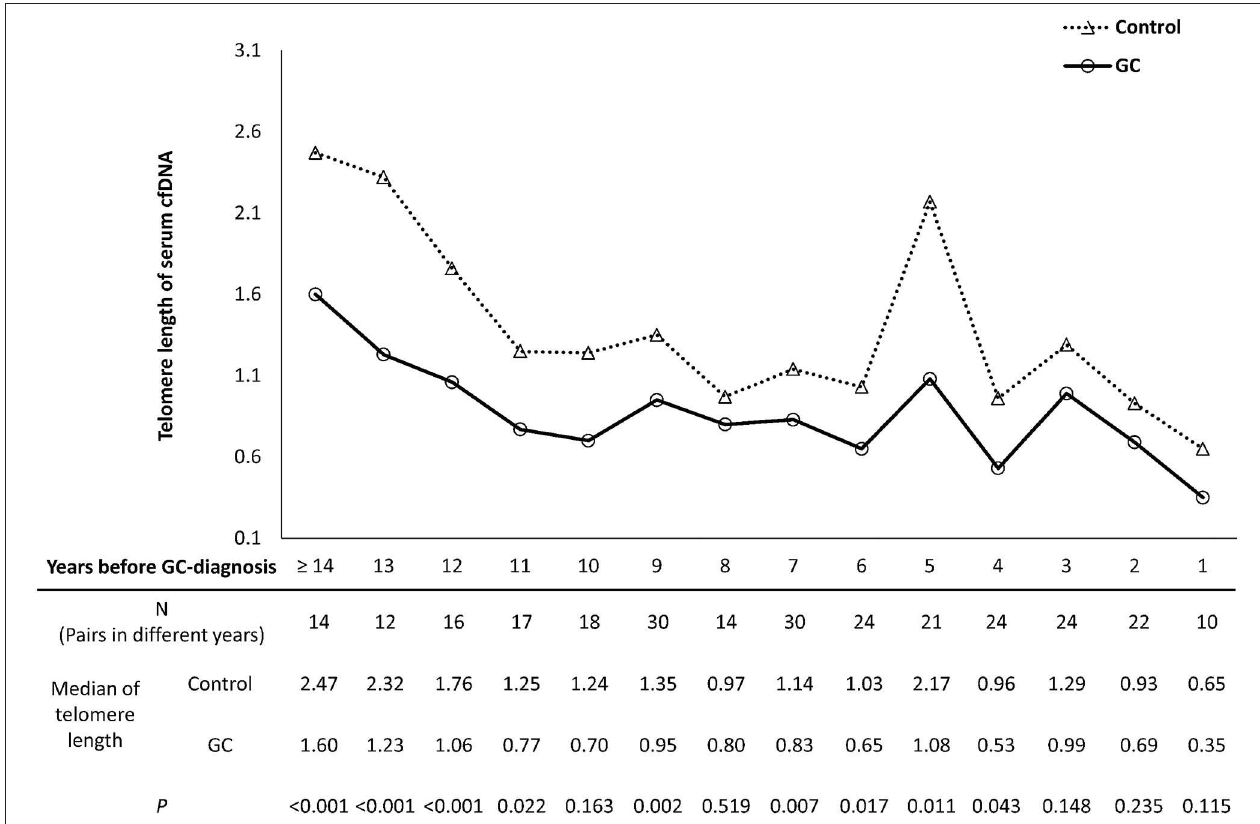
FIGURE 1 | The temporal trends of cfDNA telomere length in GC and control groups. The X axis presents the years before GC-diagnosis of pre-diagnostic samples from GC subjects. The number of sample pairs was shown in each group, and the P -values were calculated by linear regression with adjusting age variable between GC and control